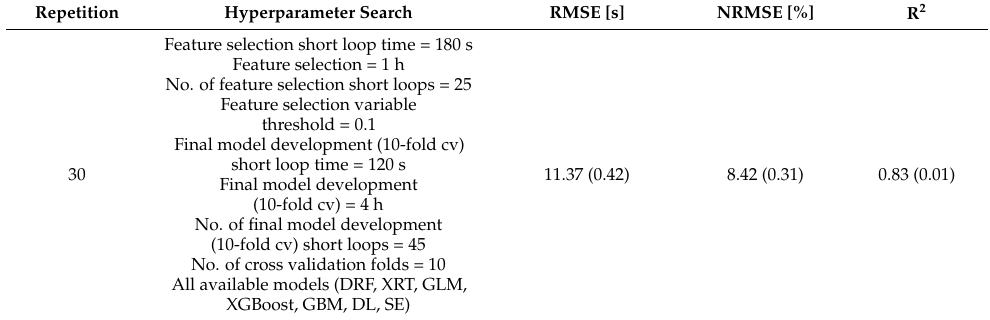
Table 3. Hyperparameters and robustness of the H2O AutoML model development (multistart); mean values of RMSE, NRMSE, and R 2 are provided for the developed models in a multistart procedure with 30 repetitions; standard deviation is in round brackets. DRF, distributed random forest; XRT, extremely randomized trees; GLM, generalized linear model; XGBoost, extreme gradient boosting machine; GBM, gradient boosting machine; DL, deep learning (fully connected multilayer artificial neural network); SE, stacked ensemble.